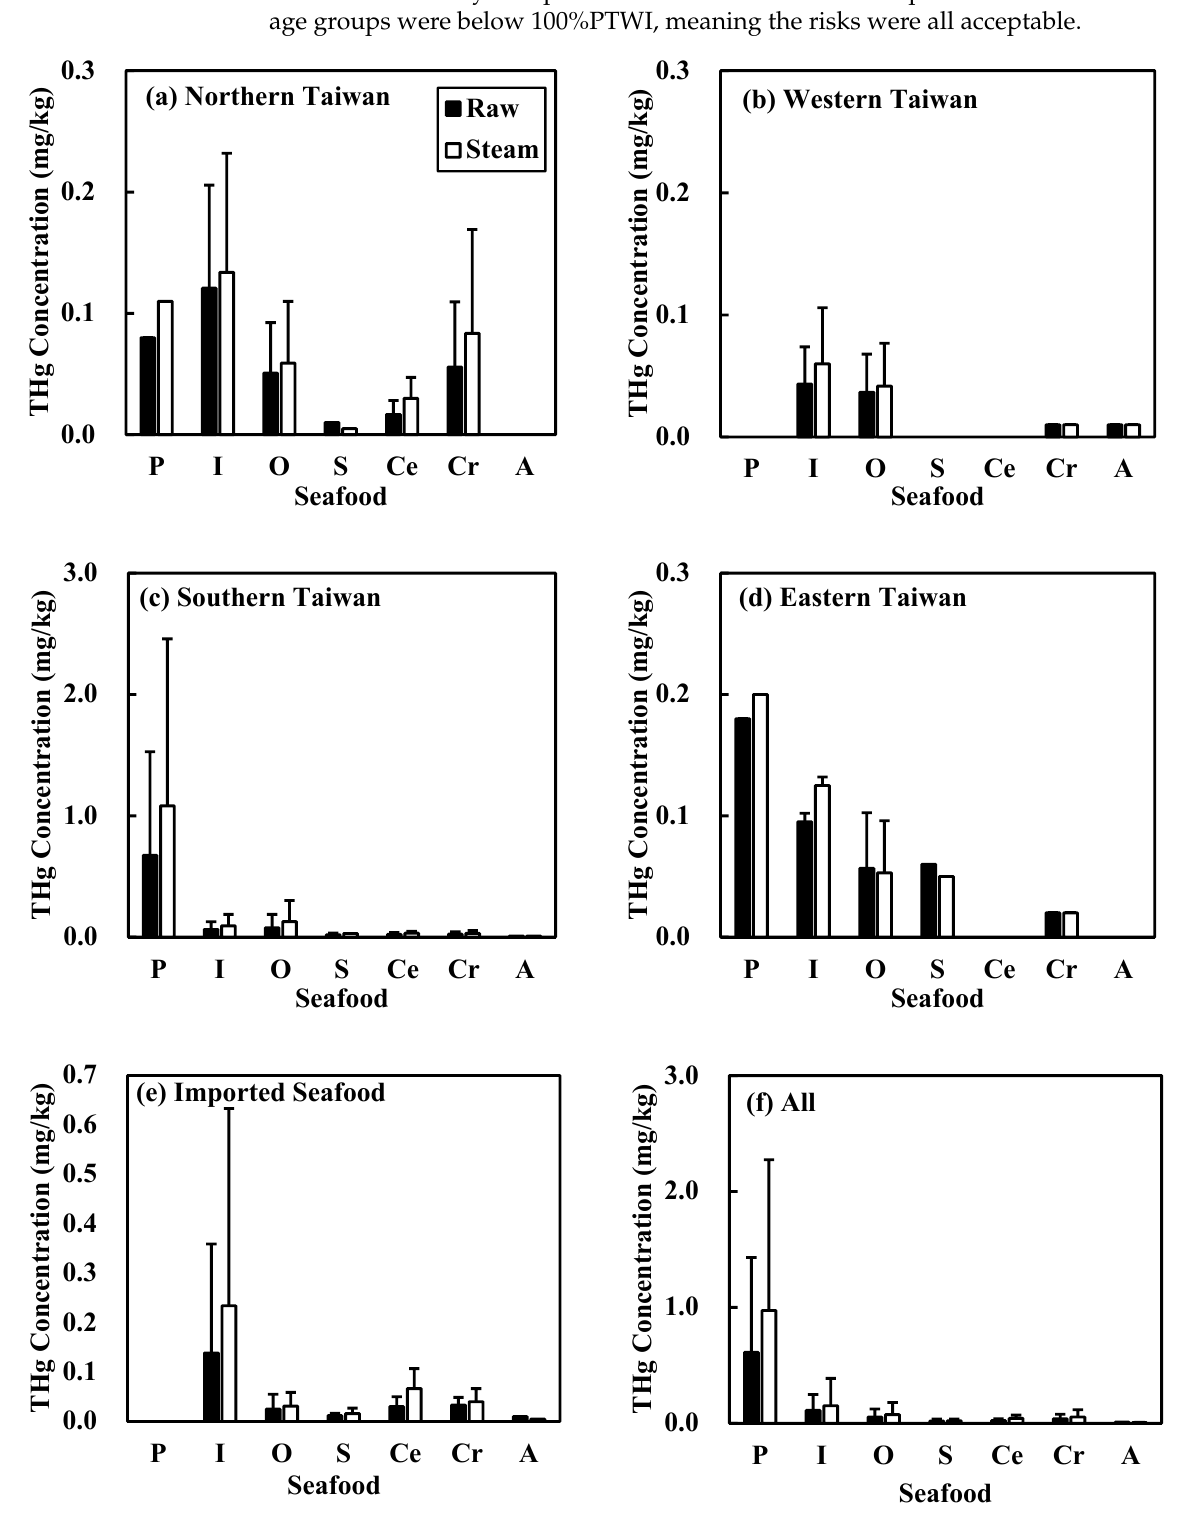
Figure 1. Concentrations of total mercury (THg) in seafood from different sources in ( a ) northern Taiwan, ( b ) western Taiwan, ( c ) southern Taiwan, ( d ) eastern Taiwan, ( e ) imported seafood, and ( f ) all purchased seafood. P: Pelagic fish; I: Inshore fish; O: Other farmed fish; S: Shellfish; Ce: Cephalopods; Cr: Crustaceans; and A: